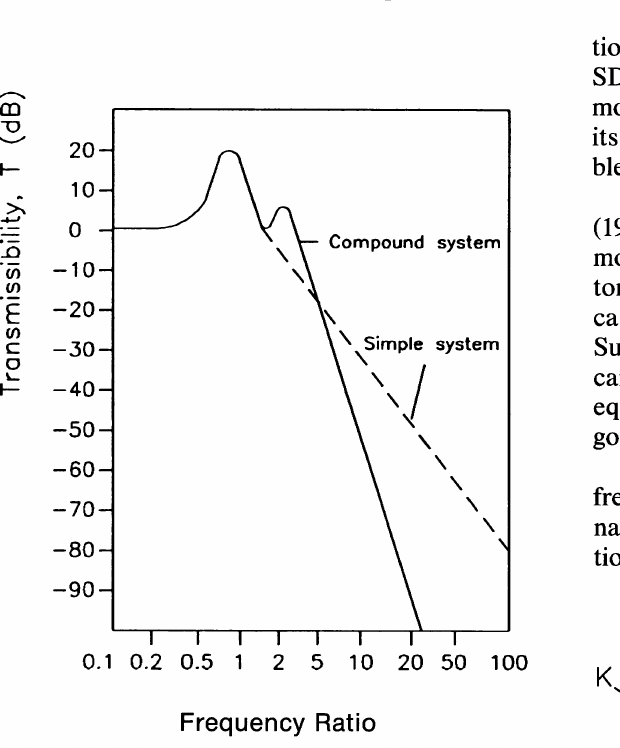
FIGURE 6 Transmissibility of a two-stage isolation system such as that shown in Fig. 5. The location of the second resonant peak depends on the mass ratio, ml/m2'